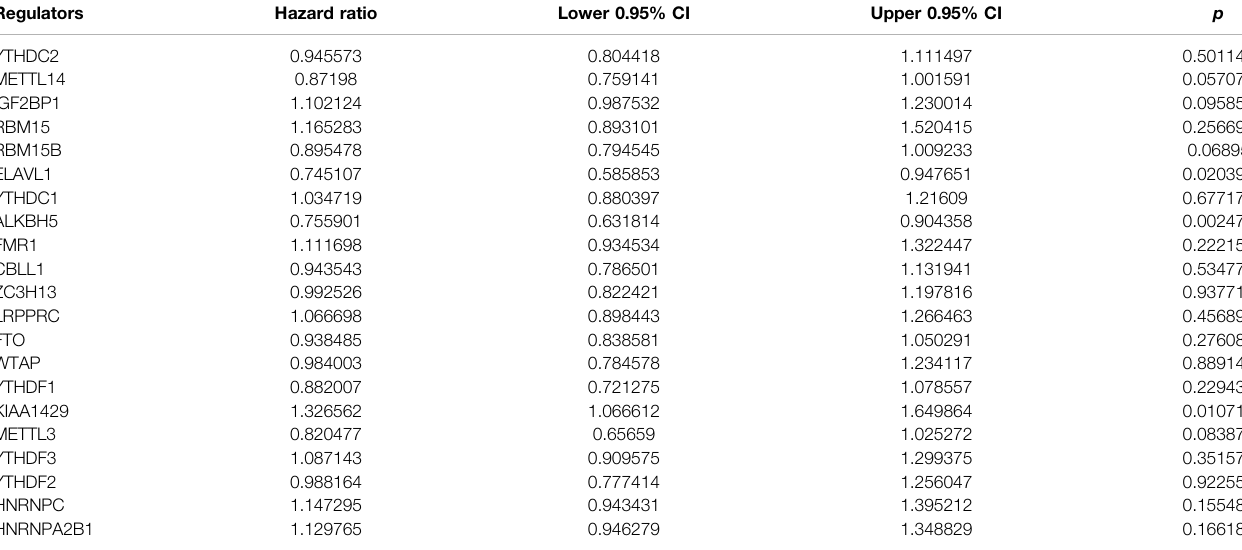
TABLE 2 | Associations between m 6 A regulators and prognoses of pancreatic cancer.